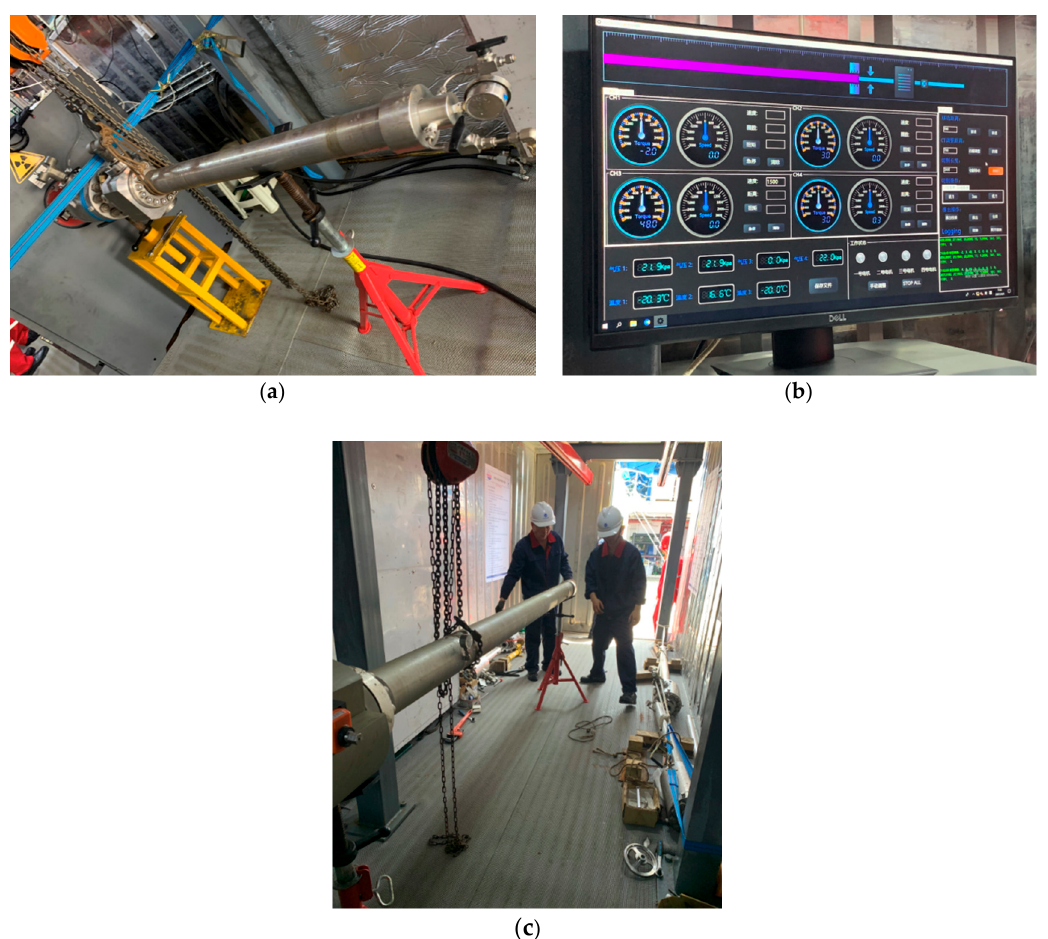
Figure 21. Experimental scene diagram: ( a ) Equipment diagram of experimental scene; ( b ) The data display diagram of the experimental scene; ( c ) Experimental scene operation diagram.